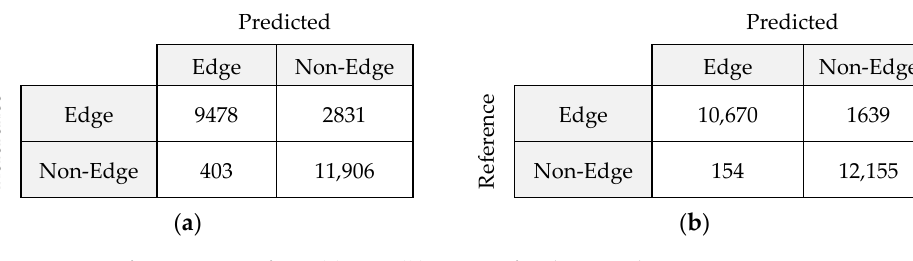
Figure 12. Confusion matrix from ( a ) SAE ( b ) GFSAE for the CEF dataset. Table 6. Accuracy metrics of boundary areas for SAE and GFSAE for the CEF dataset.